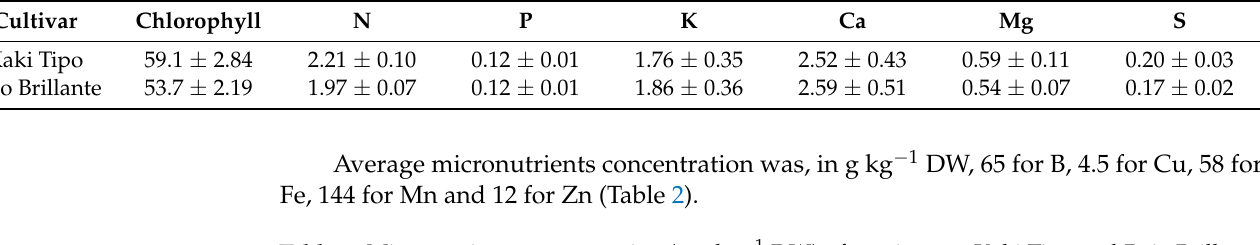
Table 2. Micronutrients concentration (mg kg − 1 DW) of persimmon Kaki Tipo and Rojo Brillante leaves sampled in summer (mean ± SD, n = 20).